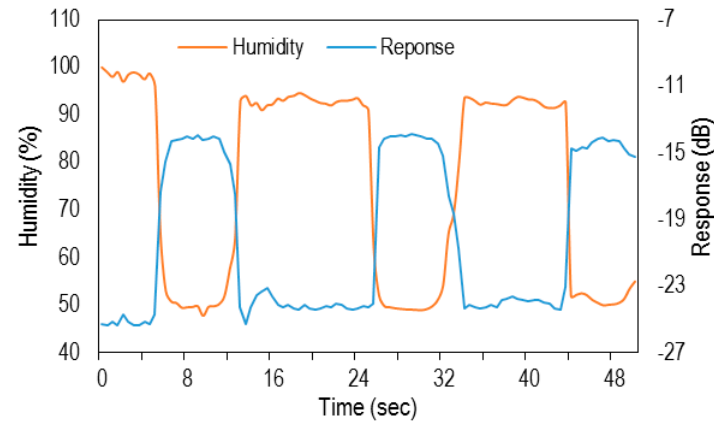
Figure 8. Observed response and recovery behavior of the humidity sensor for a cyclic humidity perturbation.